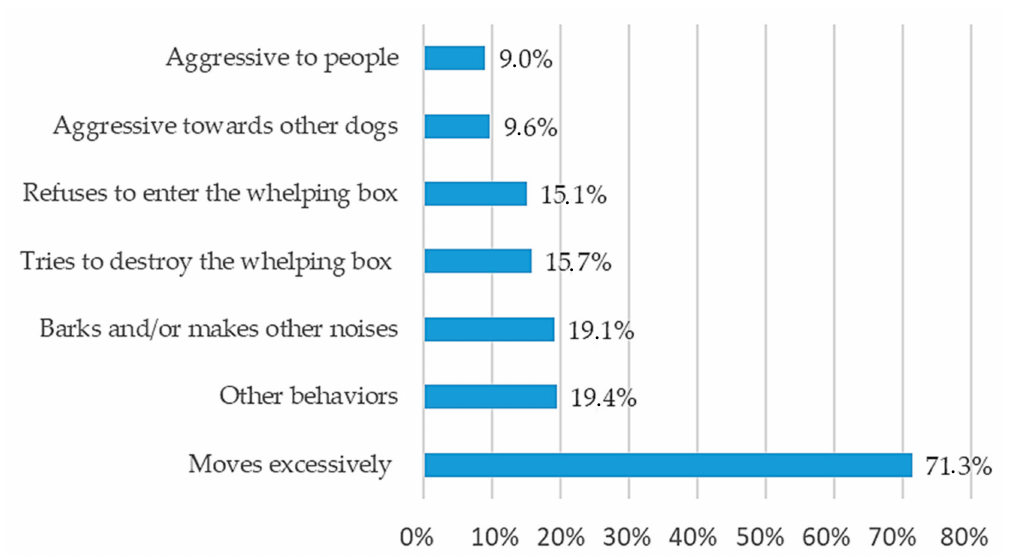
Figure 8. Common behaviors reflecting stress of the bitch at whelping in the breeders’ opinion (multiple answers allowed).